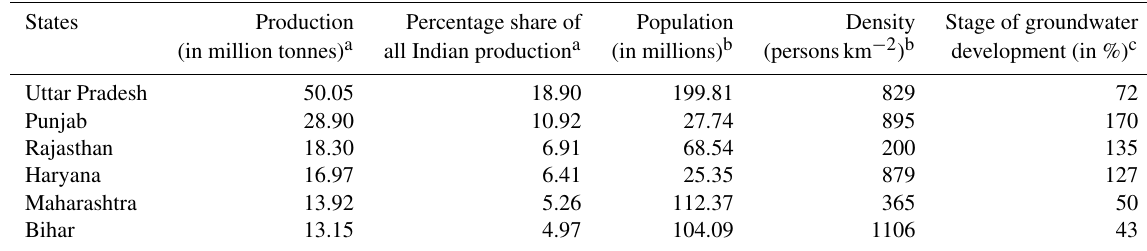
Table 1. Food grain production and groundwater development statistics of the sub-regions. States Production Percentage share of